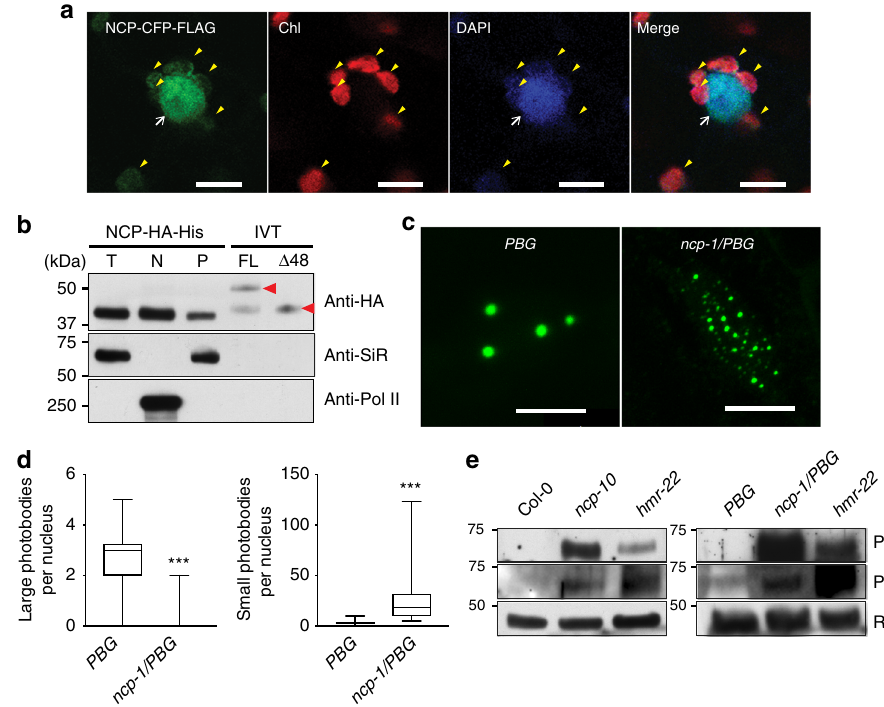
Fig. 3 NCP participates in photobody biogenesis and PIF degradation in the nucleus. a Confocal images showing the subcellular localization pattern of transiently expressed NCP-CFP-FLAG in tobacco leaf cells. NCP-CFP-FLAG signals (green) were detected in chloroplasts (marked by yellow arrowheads) and the nucleus (indicated by a white arrow). The nucleus was labeled with DAPI. Chloroplasts were labeled with DAPI in the blue channel, as well as by chlorophyll auto fl uorescence in the red channel. Scale bars represent 10 μ m. b Immunoblots showing NCP-HA-His from total, (T), nuclear (N), and plastidial (P) protein fractions of 2-day-old NCP-HA-His / ncp-10 seedlings grown in 10 μ mol m − 2 s − 1 R light. In vitro translated (IVT) NCP-HA-His and NCP Δ 48-HA-His (indicated by red arrowheads) were used as molecular size controls. The HA-tagged NCP proteins were detected via anti-HA antibodies. Ferredoxin:sul fi te reductase (SiR) and RNA Pol II were used as controls for the plastidial and nuclear fractions, respectively. c Confocal images of PHYB- GFP photobodies in epidermal cells from the top one third of the hypocotyls of 4-day-old PBG and ncp-1/PBG seedlings grown in 10 μ mol m − 2 s − 1 R light. Scale bars represent 5 μ m. d Box-and-whisker plots showing the numbers of large (>0.73 μ m 3 , left panel) and small (<0.73 μ m 3 , right panel) photobodies per nucleus in the epidermal cells of the top one third of the hypocotyls of PBG and ncp-1/PBG seedlings. The boxes represent from the 25th to the 75th percentiles, the whiskers extend to the maximum and minimum data points, and the center lines in each box indicate the median value. Asterisks (***) indicate a statistically signi fi cant difference between the value in ncp-1/PBG and that in PBG (Student ’ s t -test, p ≤ 0.001). e Immunoblots showing the PIF1 and PIF3 levels in 4-day-old Col-0, ncp-10, hmr-22 , PBG , and ncp-1/PBG seedlings grown in 10 μ mol m − 2 s − 1 R light. RPN6 was used as a loading control. The source data for immunoblots in b , e and photobody analysis in d are provided in Source Data fi